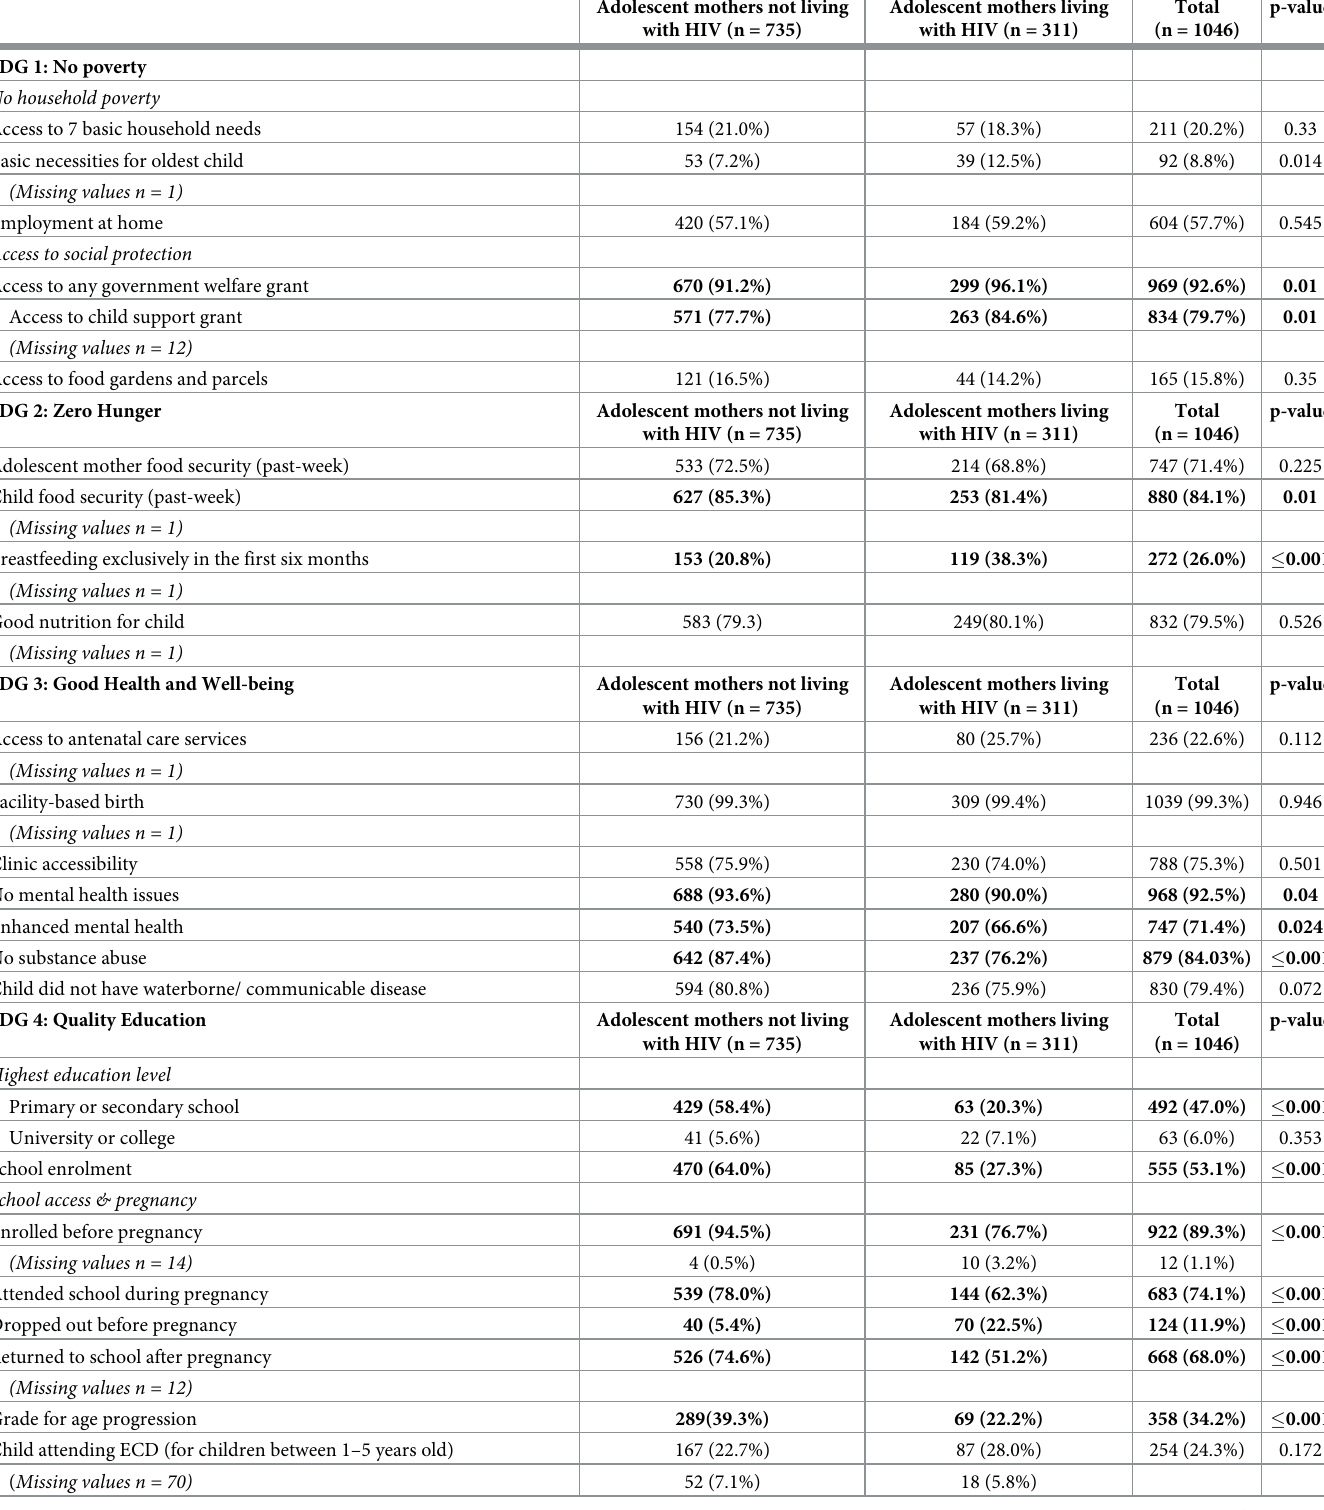
Table 2. SDGs-aligned outcomes among adolescent mothers and their